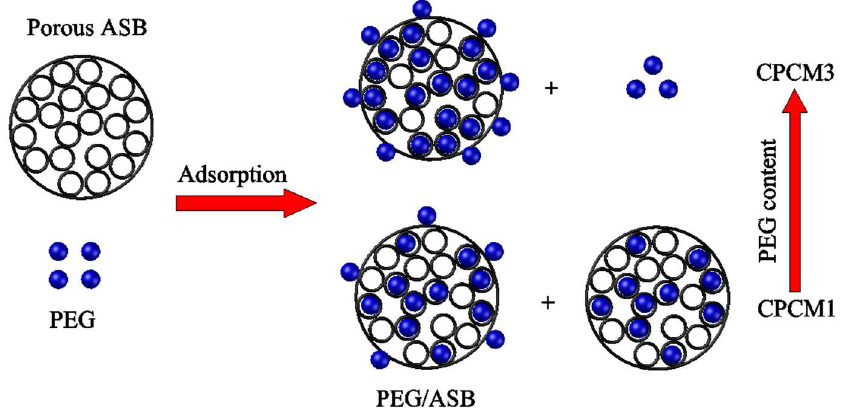
Figure 7. Schematic illustration of the interaction between PEG and ASB.